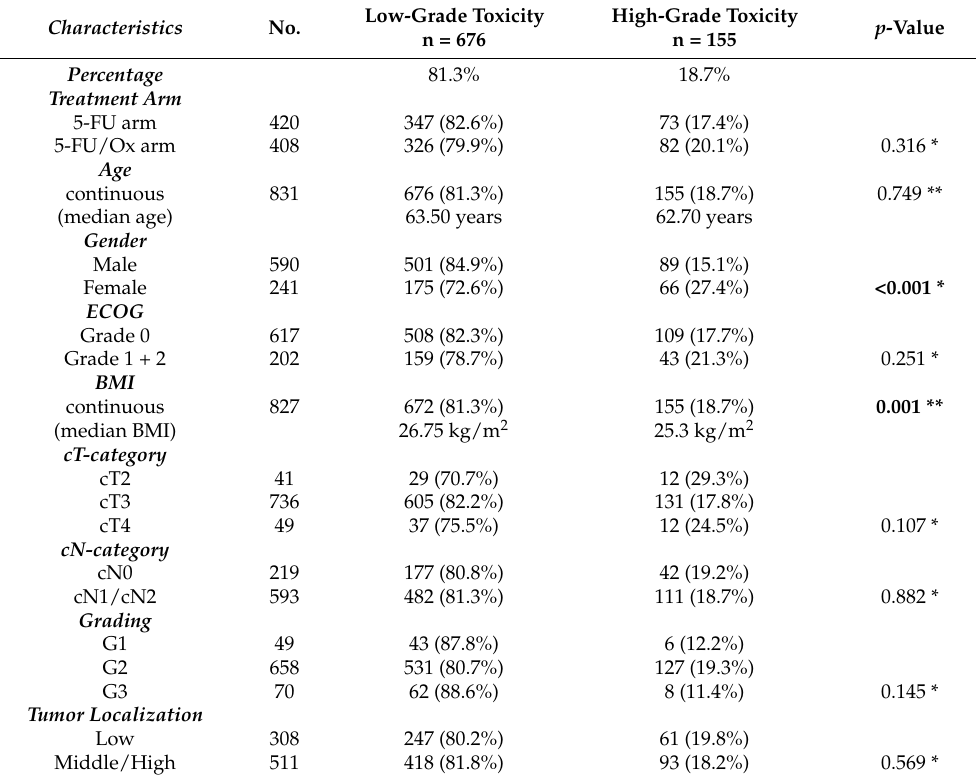
Table 1. Association between baseline clinical characteristics and toxicity in the development cohort.